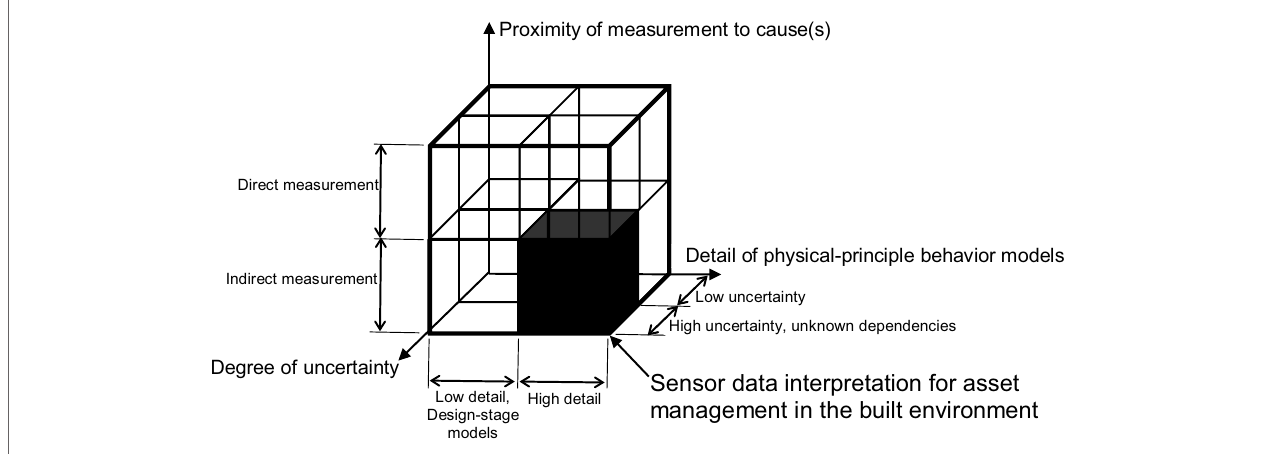
FiGURe 1 | Sensor data interpretation for asset management in the built environment is performed with detailed physical-principle models that are improved through indirect measurements under conditions of high levels of uncertainty and unknown dependencies between measurement positions . The best data interpretation strategies in other contexts may differ from those that are the best in this